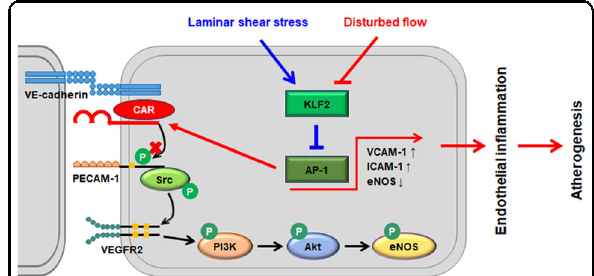
Fig. 6 Schematic of the proposed role of CAR in endothelial mechanotransduction signaling under FSS. Endothelial CAR expression is regulated by FSS. Disturbed fl ow increases, whereas laminar shear stress decreases, CAR expression in ECs; these changes in CAR expression are regulated through the KLF2-AP-1 axis. Disturbed fl ow-induced CAR inhibits the phosphorylation of PECAM-1, leading to the suppression of endothelial mechanotransduction signaling through the phosphorylation of Src, PI3K, Akt, and eNOS. Therefore, CAR modulates mechanotransduction in ECs by blocking PECAM-1 phosphorylation, which in fl uences endothelial function and vascular